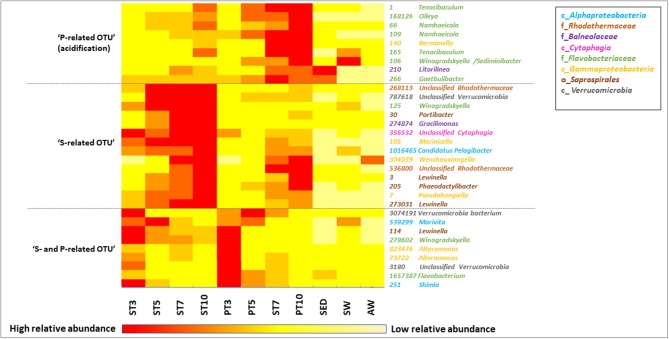
Heat map showing the relative abundance of the most discriminant OTU selected from the PCoA of initial samples (SED, SW, and AWW) and samples collected during resuspension experiments (at 4 different times from T3 to T10), either in exposed (P) or not (S) to AWW. Data are average abundances calculated on biological triplicates. The color intensity for each panel corresponds to the OTU abundance, red indicates high level of relative abundance, while yellow indicates low relative abundance.